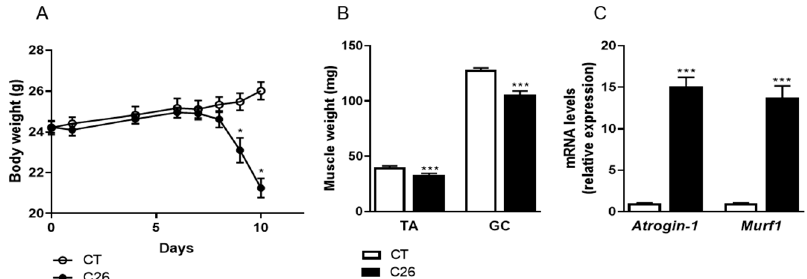
Figure 1. C26 colon carcinoma causes body weight loss and severe muscle atrophy. ( A ) Body weight evolution of male mice injected with C26 cells (C26) or vehicle (CT). ( B ) Tibialis anterior (TA) and gastrocnemius (GC) muscle weights from C26 and CT mice 10 days after injection. ( C ) Gene expression levels of major atrogens in GC muscle of C26 and CT mice. Data are reported as means ± SEM ( n = 8 / group). * p < 0.05 and *** p < 0.001 vs CT.